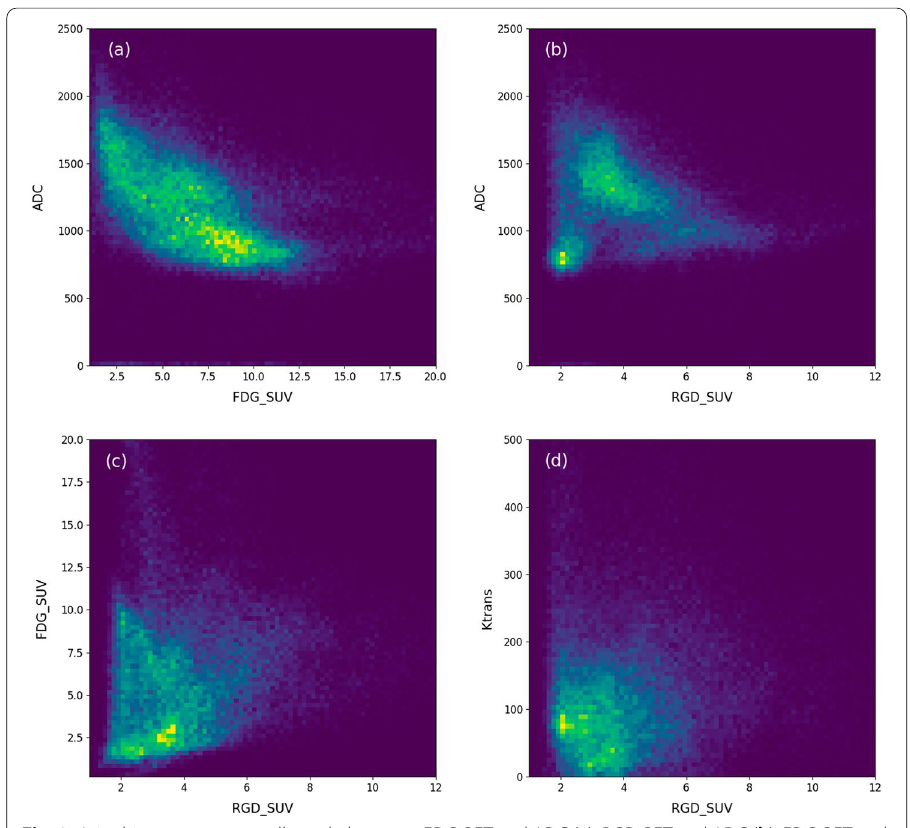
Fig. 3 Joint histograms across all voxels, between FDG-PET and ADC ( a ), RGD-PET and ADC ( b ), FDG-PET and RGD-PET ( c ), and RGD-PET and K trans ( d